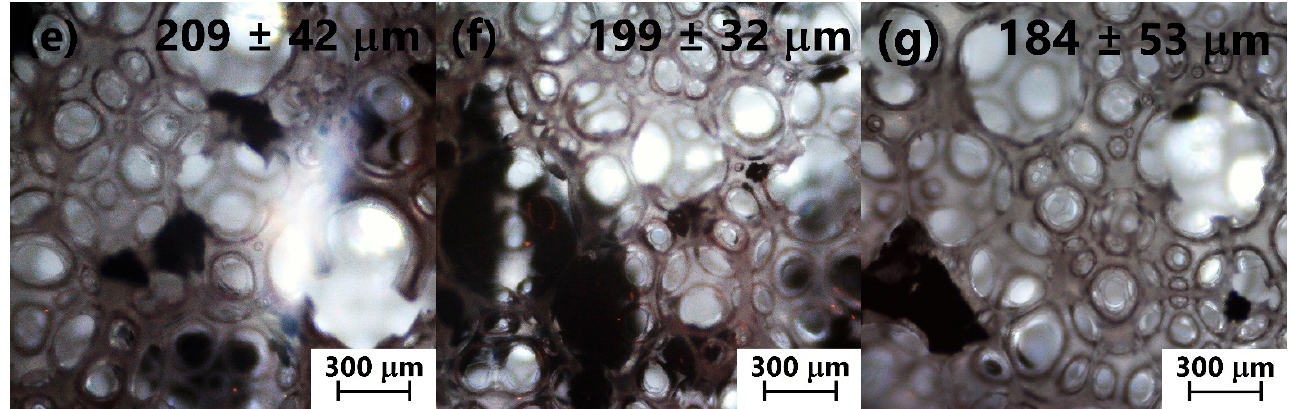
Figure 3. The exemplary images showing cellular structure of ( a ) PU, ( b ) PU/GTR, ( c ) PU/GTR TM , ( d ) PU/GTR 20FO , ( e ) PU/GTR 40FO , ( f ) PU/GTR 20WO , and ( g ) PU/GTR 40WO foams. PU: the neat foam without the addition of ground tire rubber (GTR).